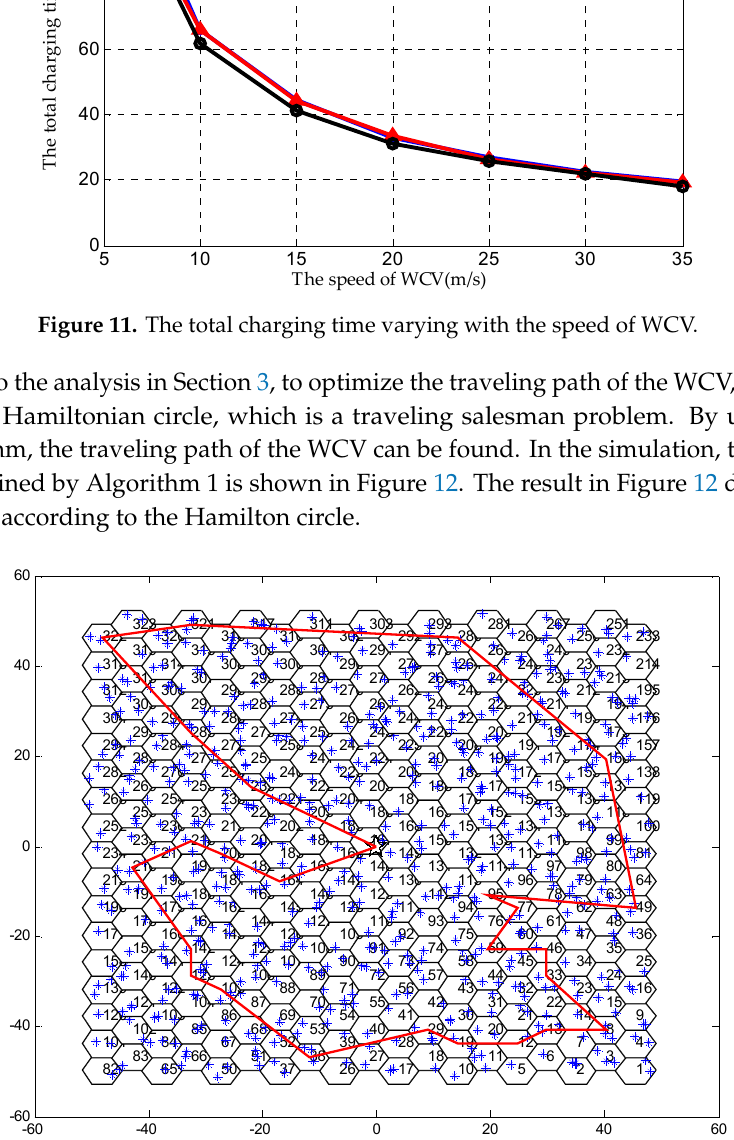
Figure 11. The total charging time varying with the speed of WCV.